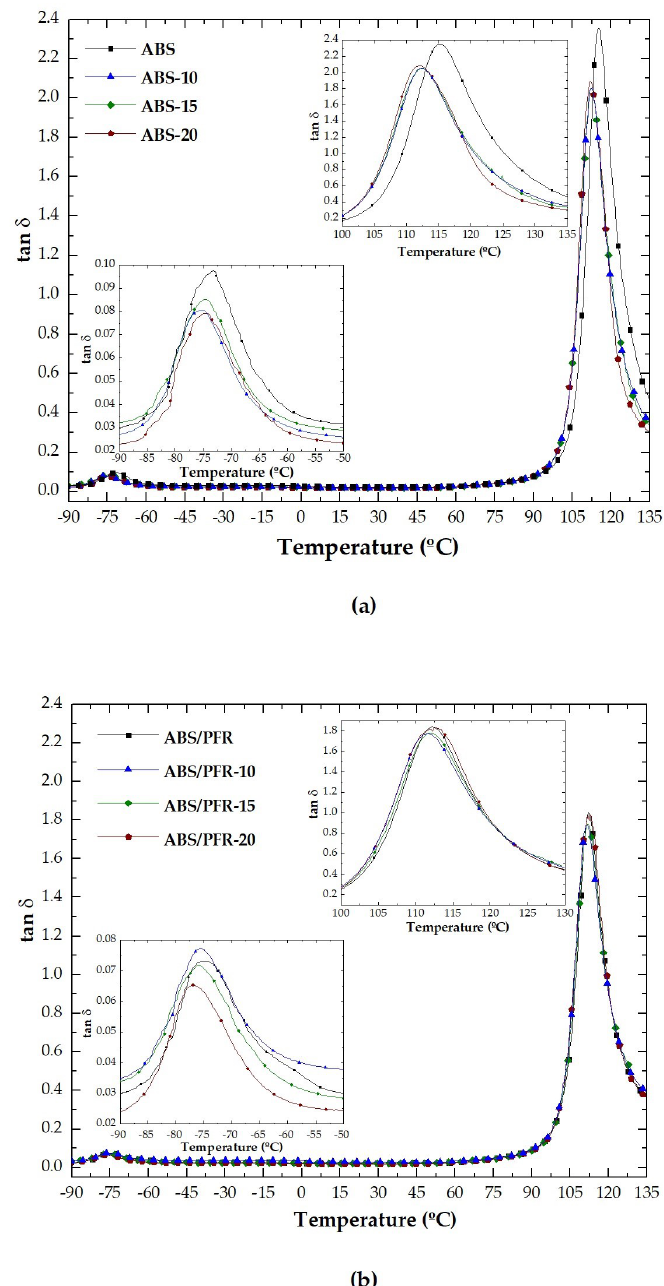
Figure 7. Evolution of the tan δ with temperature for the unfoamed and foamed ( a ) ABS and ( b )